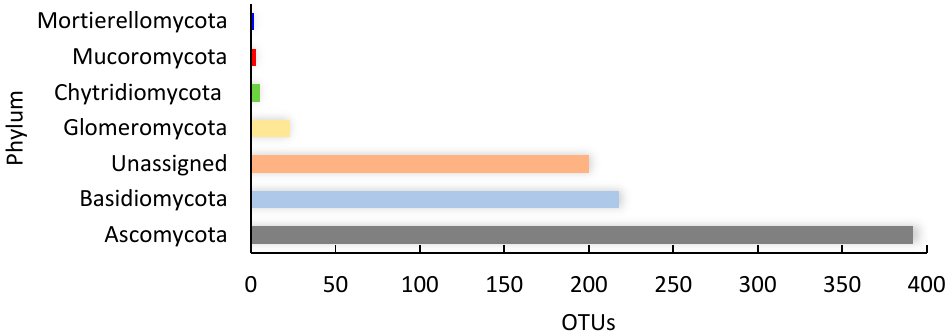
Figure 1. OTU frequencies of the mycorrhizal and root-associated endophytic fungi associated with Maxillaria acuminata .